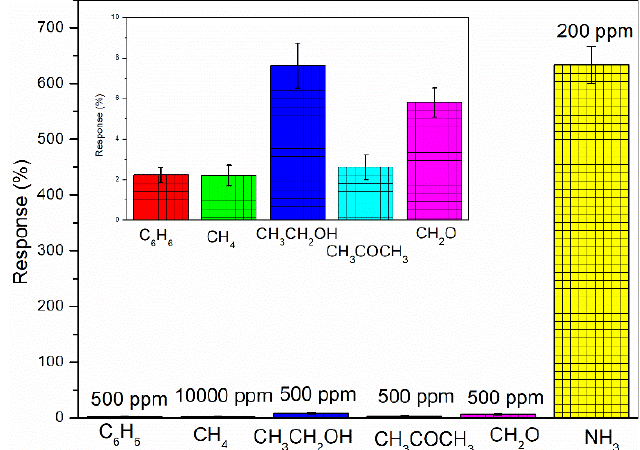
Figure 8. The selectivity of BP/PANI thin film to various gases.